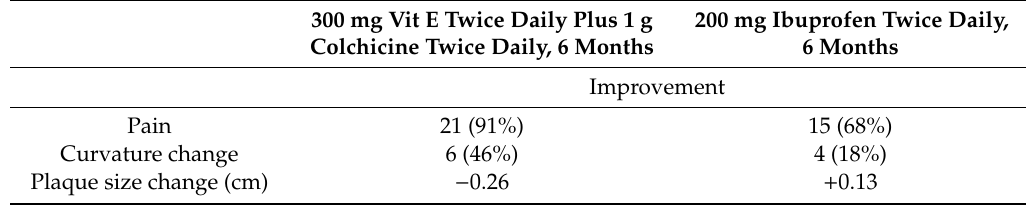
Table 10. Vitamin E plus Colchicine vs. Ibuprofen: Randomized, Single-Blind.